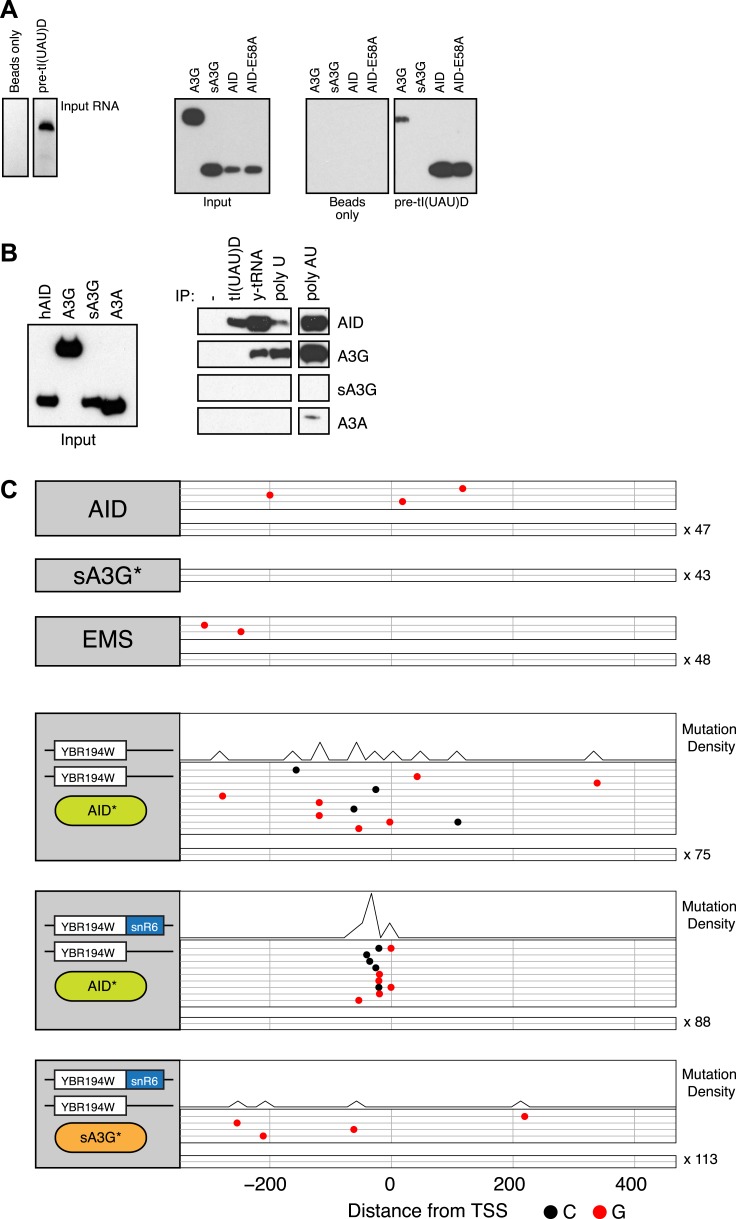
RNA binding by human AID and APOBEC3G.(A) Left panel shows the in vitro transcribed pre-tI(UAU)D tRNA used for affinity purification. Right panel shows immunoblots for transiently overexpressed AID/APOBEC3G proteins following RNA-immunoprecipitation with pre-tRNA. (B) Affinity purification with tl(UAU)D probe, total yeast tRNA, homopolymeric single stranded (polyU) and double stranded (polyA:U) RNA. Left panel shows input proteins, right panel shows immunoblots for transiently overexpressed AID/APOBEC3 proteins following RNA-immunoprecipitation. Results representative of at least 3 independent experiments. (C) Deaminase induced mutations in the promoter region of the YBR194W locus. Top panels: accumulated mutations in the AID*, sA3G* and EMS whole genome datasets. Bottom panels: mutations detected in Sanger sequenced yeast clones unmodified or harbouring a chimeric YBR194W-snR6 locus. Each line represents one clone with dots representing mutations (at C, black; at G, red). Clones with no mutations are indicated.